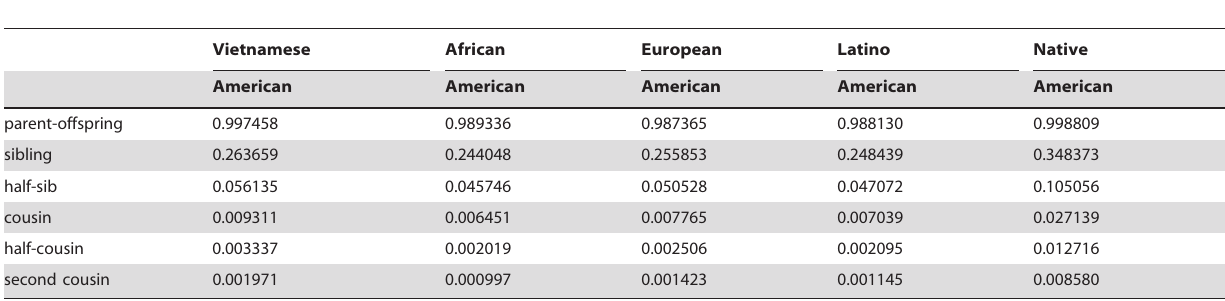
Table 3. Parent-offspring test identification rates for different Y-sharing relatives and population